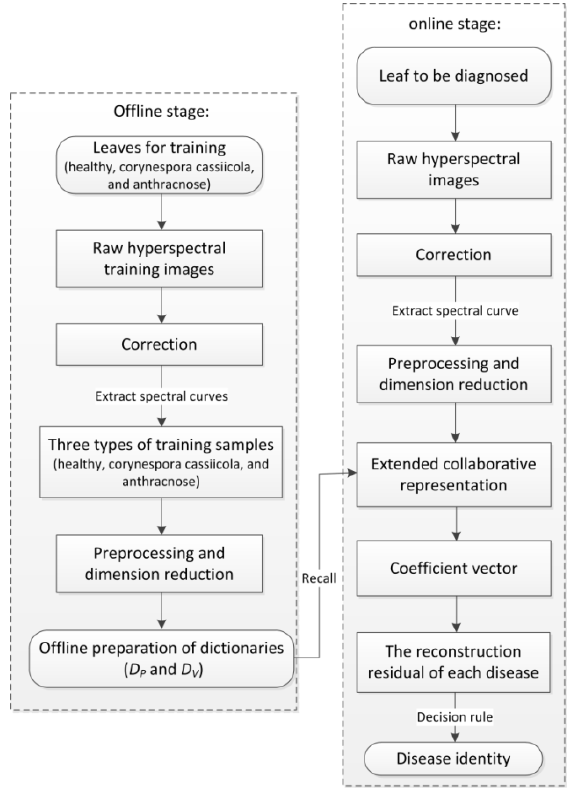
Figure 2. The flowchart for cucumber disease recognition using the ECR-based classification model.